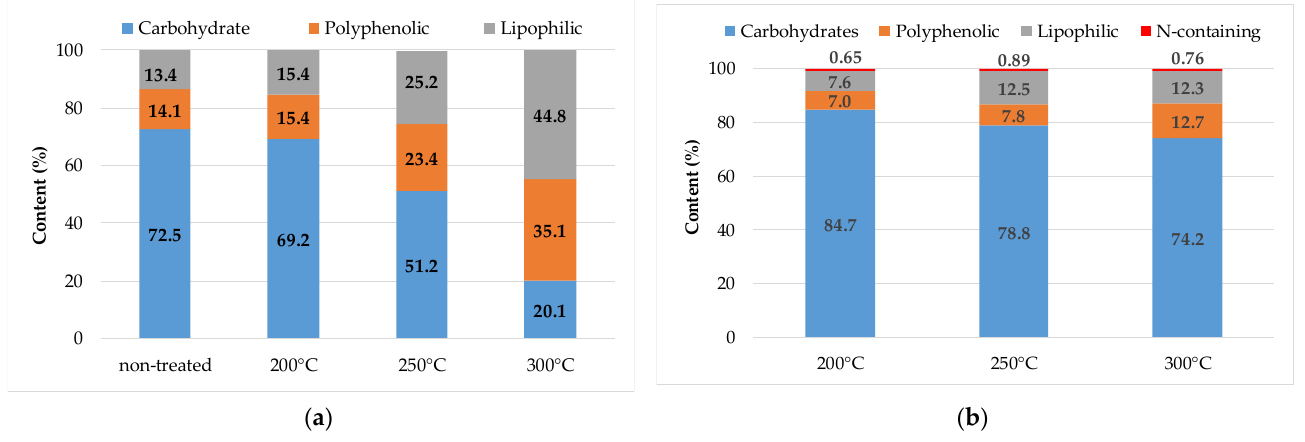
Figure 7. The relative content of carbohydrate, polyphenolic, lipophilic, and N-containing constituent-derived products in pyrolysis volatiles of non-treated and torrefied peat solid fractions ( a ), and tar fractions ( b ), depending on the treatment temperature.